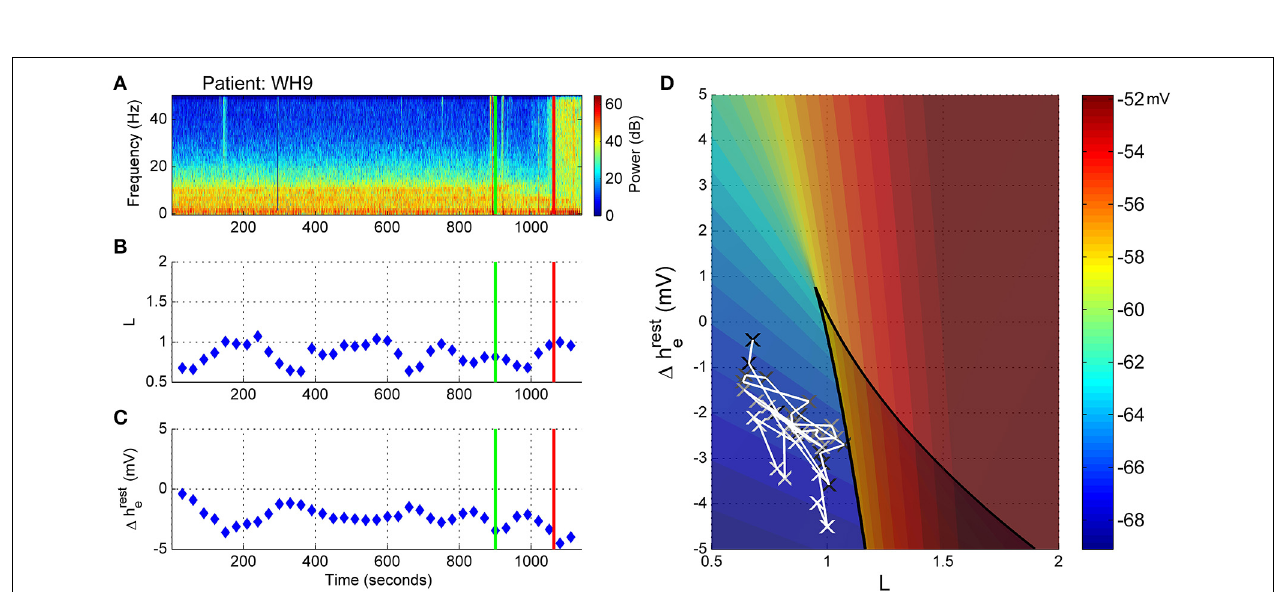
blue line, left vertical axis, and opioid levels as equivalent Fentanyl (C e Fentanyl, ng/ml), green line, right vertical axis. (D) Absolute alpha power (dB) against absolute delta power (dB) for prior to start of emergence (black circles), during emergence period (blue circles), and following recovery of response (ROR).